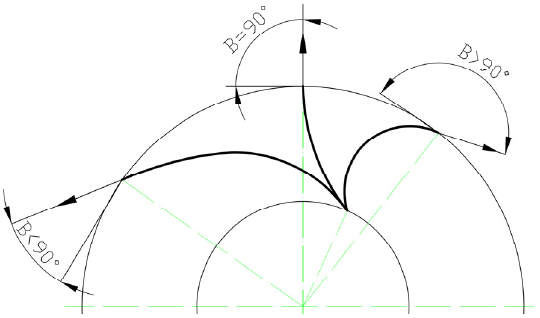
Figure 2. Rotor blade types—backward-curved, radial, and forward-curved.